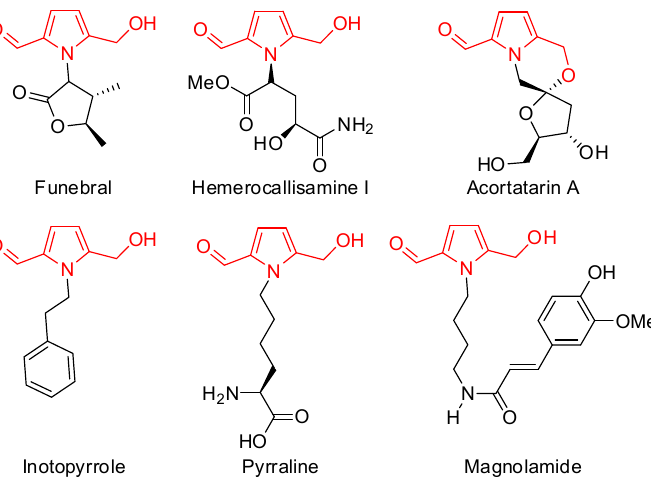
Figure 1. Structures of 2-formyl pyrrole-containing bioactive natural products.